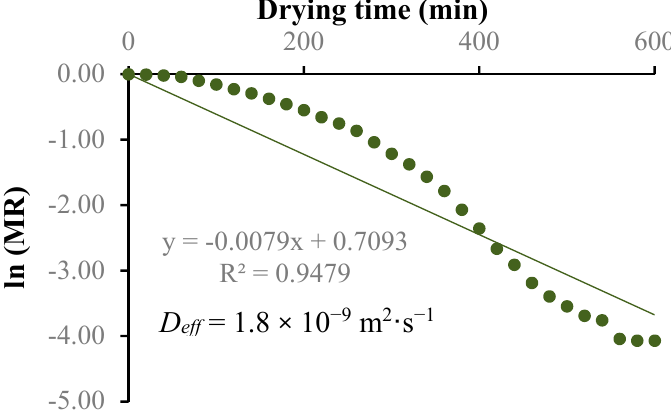
Figure 7. Linear relationship between ln(MR) and drying time for temperature value < 52 °C.